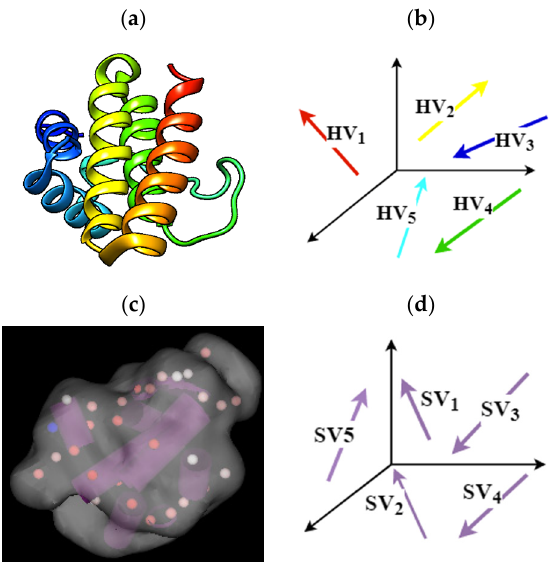
Figure 3. Construction of 3D vectors from extracted SSEs: ( a ) 3D structure of protein 1FLP (PDB ID) is shown with chimera [29]; ( b ) each α -helix in the atomic model is considered as a helix vector (HV) in the Cartesian coordinate system ( R 3 ); ( c ) the cryo-EM density map and the SSEs-C detected on it. The map is simulated at 10 Å resolution using protein structure 1FLP (PDB ID). The location of SSEs-C is illustrated as purple cylinders with Gorgon [21]; ( d ) extracted SSEs-C on the map considered as stick vector (SV) in three-dimensional Cartesian space R 3 SSEs − C